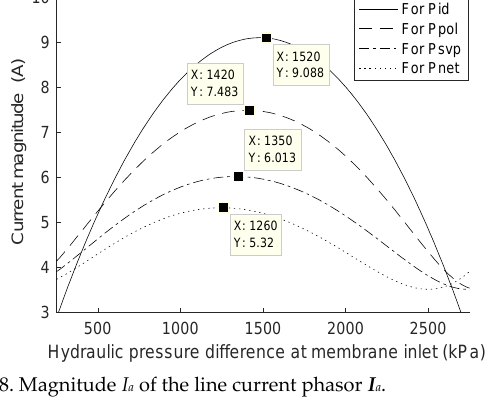
Fig. 8. Magnitude I a of the line current phasor I a . T ABLE